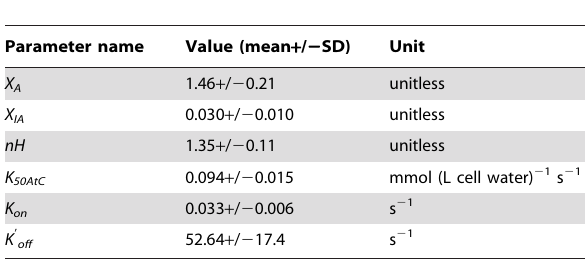
Table 4. Parameter values model configuration ii , parallel activation at complex